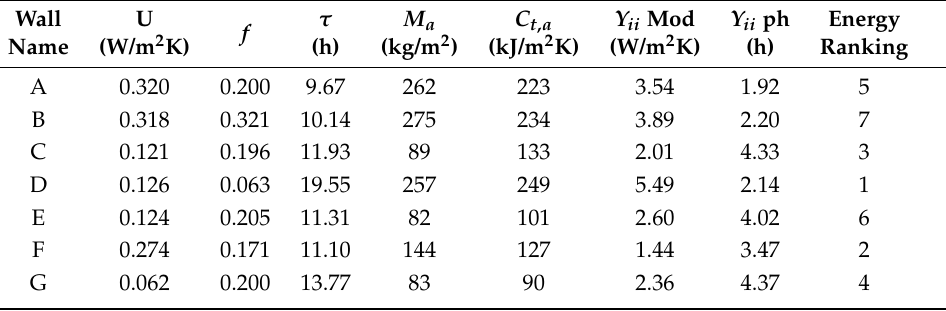
Figure 9. Energy analysis. Left : mass and thermal capacity. Right : indoor admittance (mod, phase). Table 1. Energy performance and ranking of the investigated wall